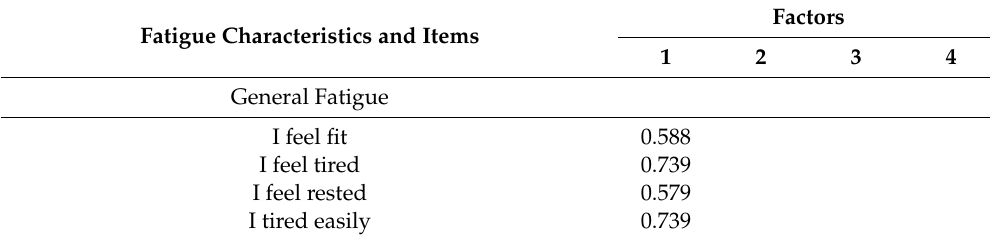
Table 5. Factor analysis of Multidimensional Fatigue Inventory (MFI) 16-items